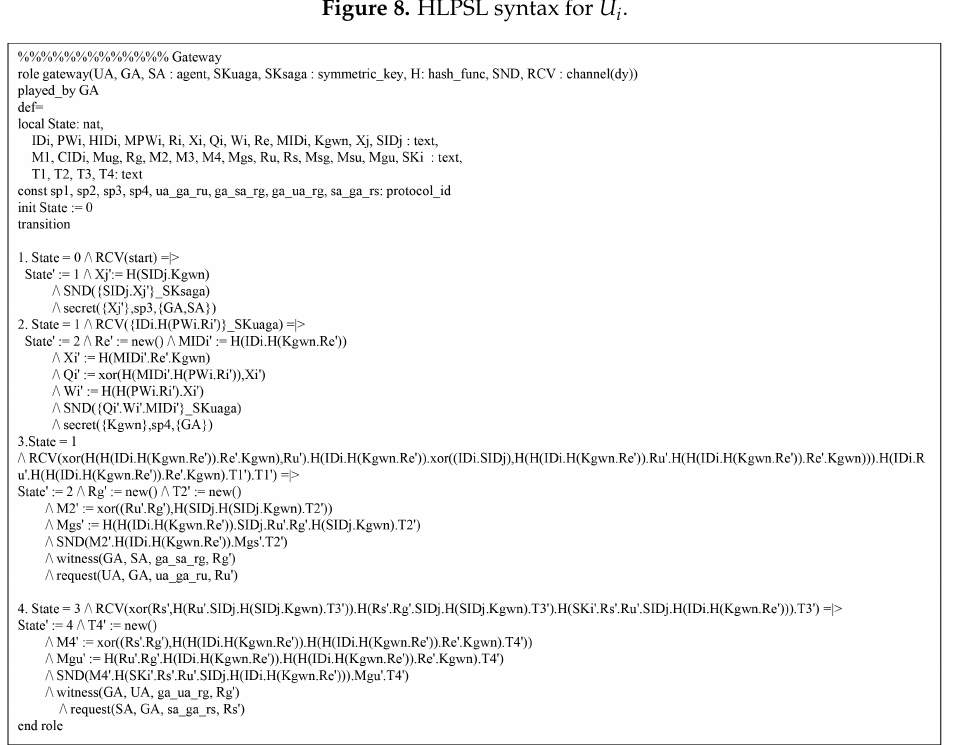
Figure 8. HLPSL syntax for U i .